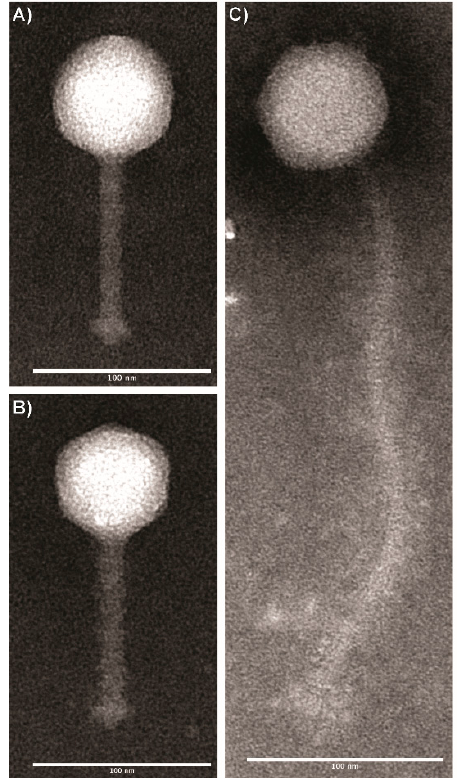
Table 3. Morphology of Listeria monocytogenes phages.